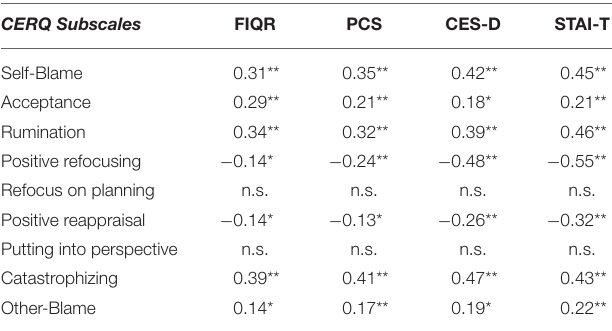
TABLE 4 | Intercorrelations between the CERQ Subscales and Study